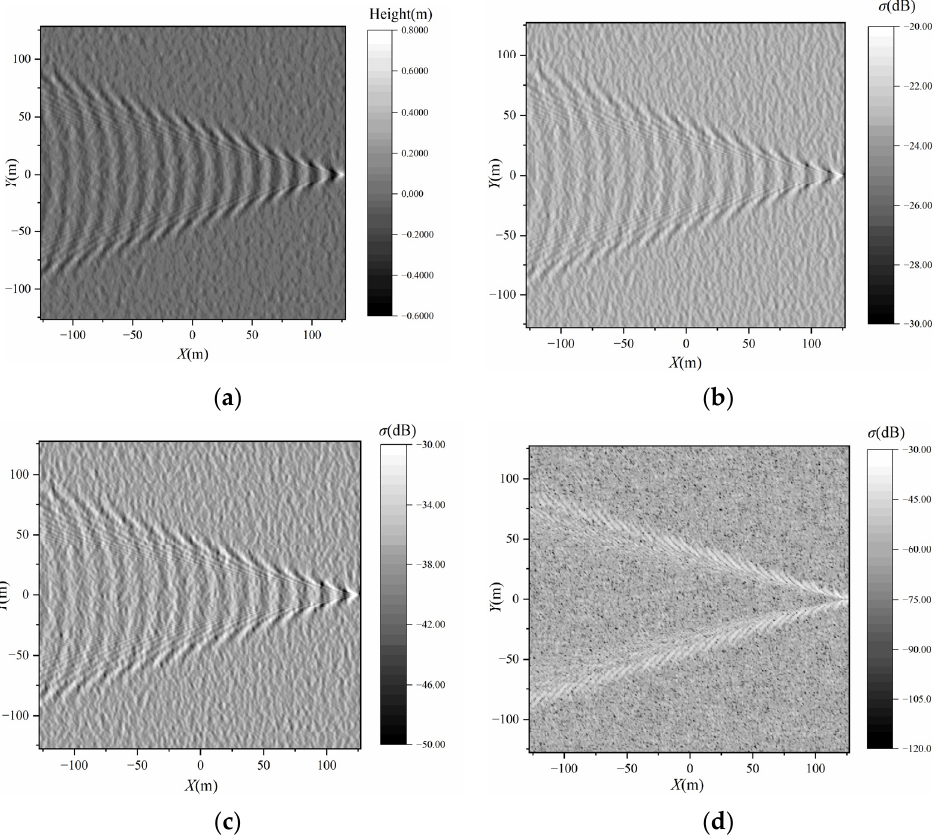
Figure 5. Ship wake surface scattering distribution in sea background. ( a ) wake model; ( b ) VV po- larization; ( c ) HH polarization; ( d ) VH polarization.